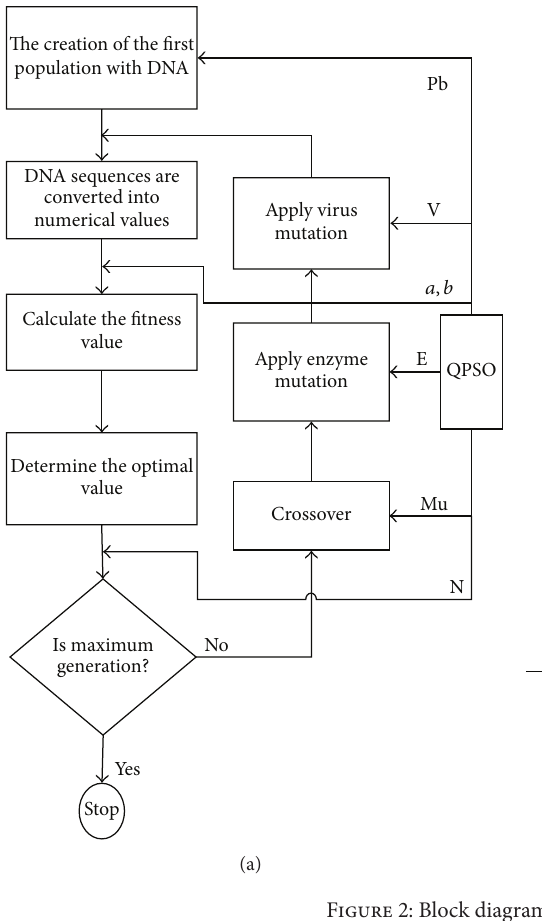
Figure 2: Block diagram of the proposed approach.